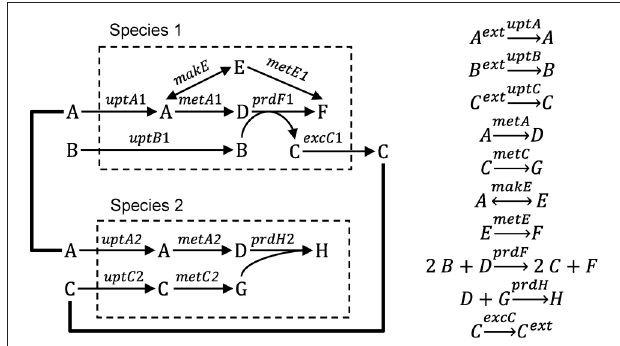
FIGURE 1 | Hypothetical ecosystem used to illustrate different modeling approaches. Species 1 takes up metabolites A and B, produces metabolites C, D, E, and F and excretes metabolite C. Species 2 takes up metabolites A and C and produces metabolites D, G, and